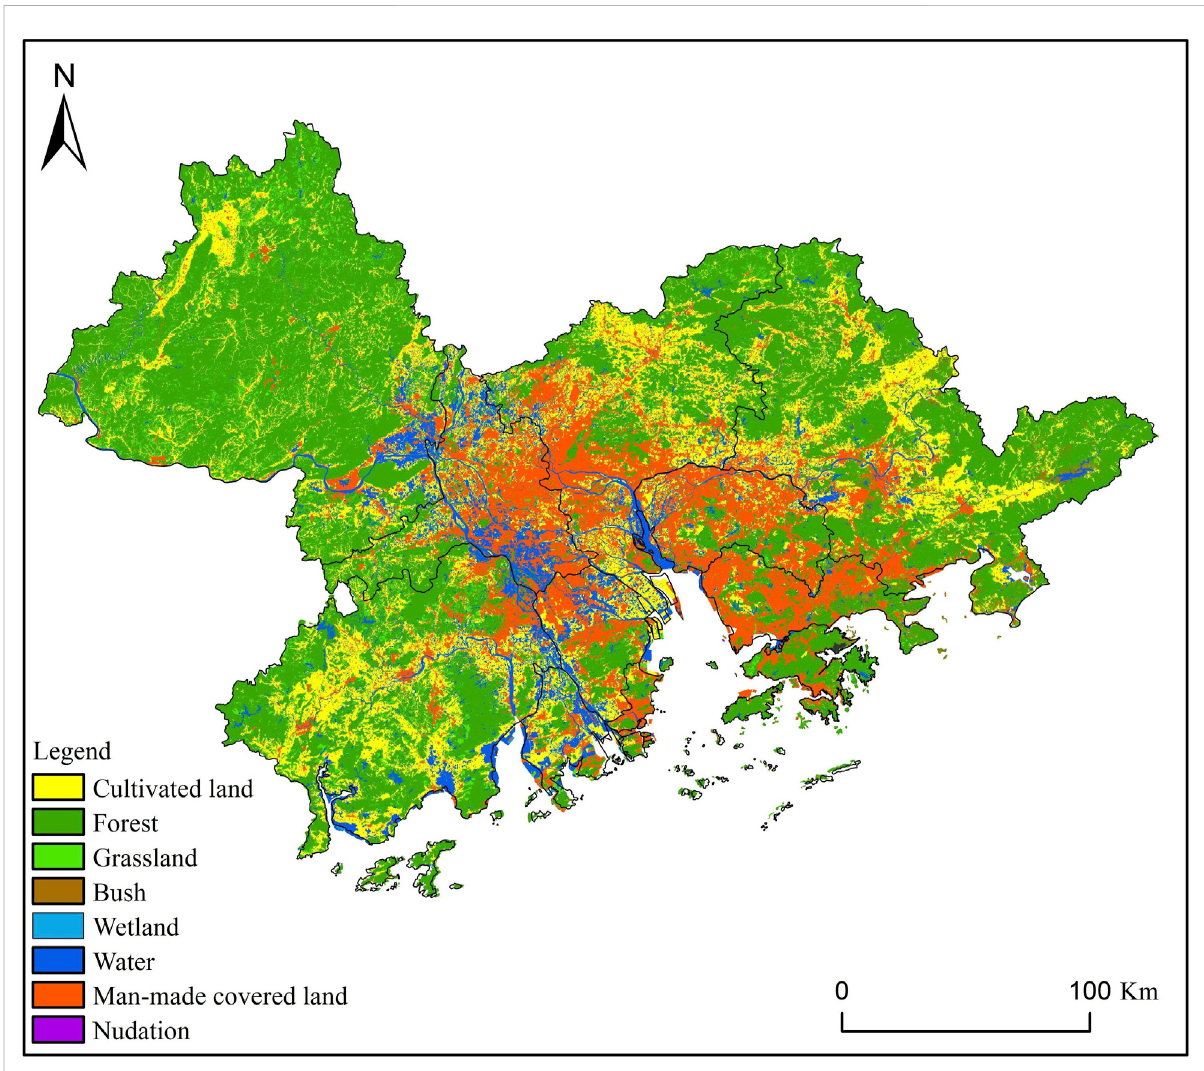
FIGURE 12 Surface cover map of the Guangdong – Hong Kong – Macau Greater Bay Area in